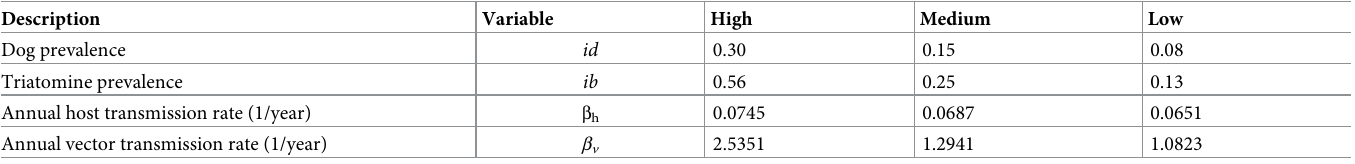
Table 2. Trypanosoma cruzi infection prevalence and transmission